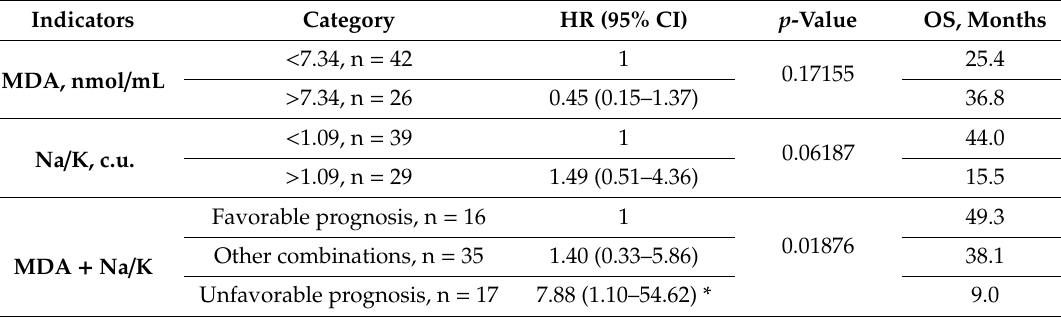
Table 4. Analysis of biochemical saliva parameters a ff ecting overall survival of OSCC